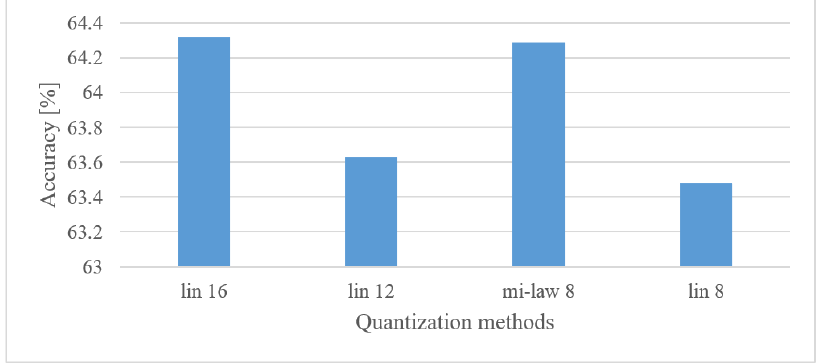
Figure 16. Averaged accuracies for 16, 12, and 8 bit linear, and 8 bit µ -law quantization schemes in the case of 1 s-long spectrograms.